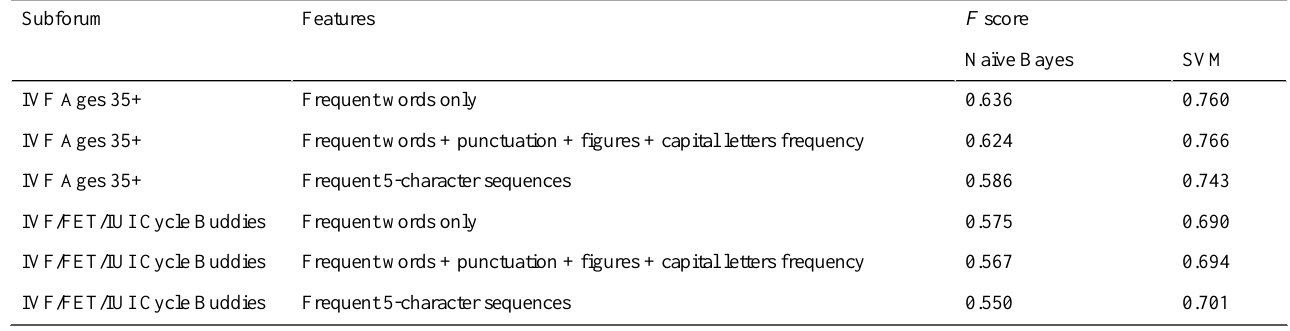
Table 9. Results for author detection task using Naïve Bayes and support vector machine (SVM) classification models implemented in WEKA.